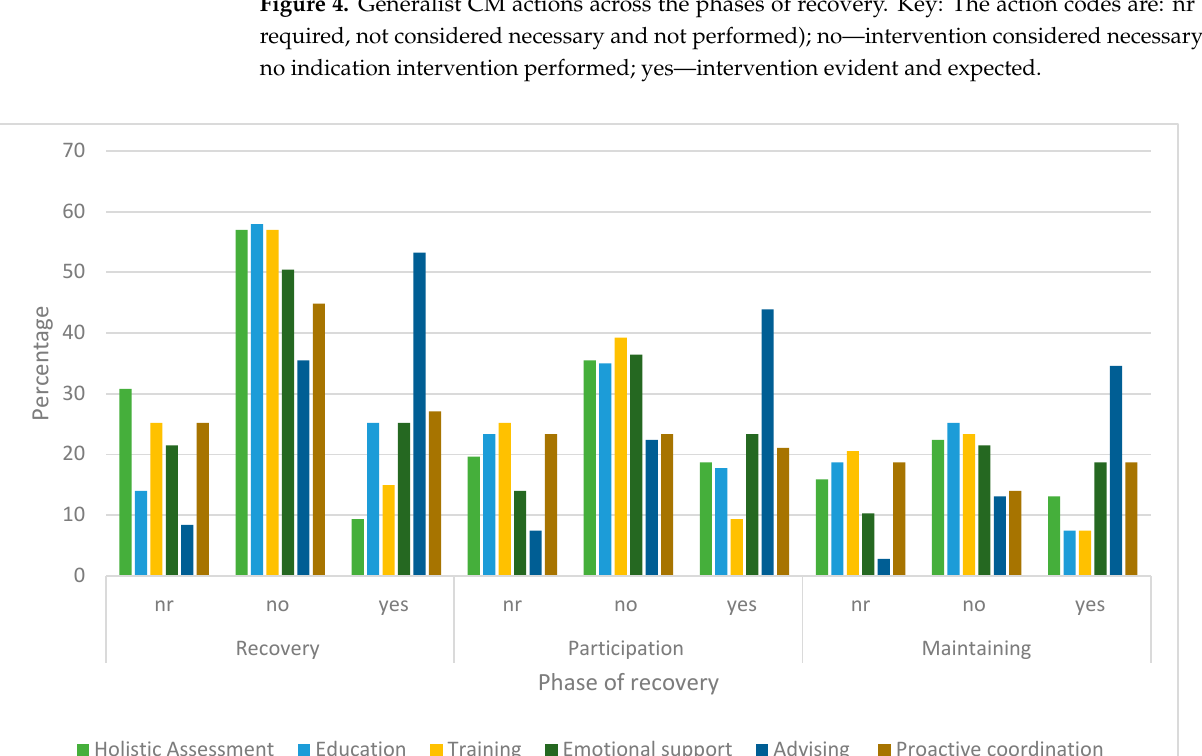
Figure 5. Person-centred CM actions across the periods. The action codes are: nr—not required, not considered necessary and not performed; no—intervention considered necessary but no indication intervention performed; yes—intervention evident and expected; yes, but n/a—intervention performed but not expected nor considered necessary.